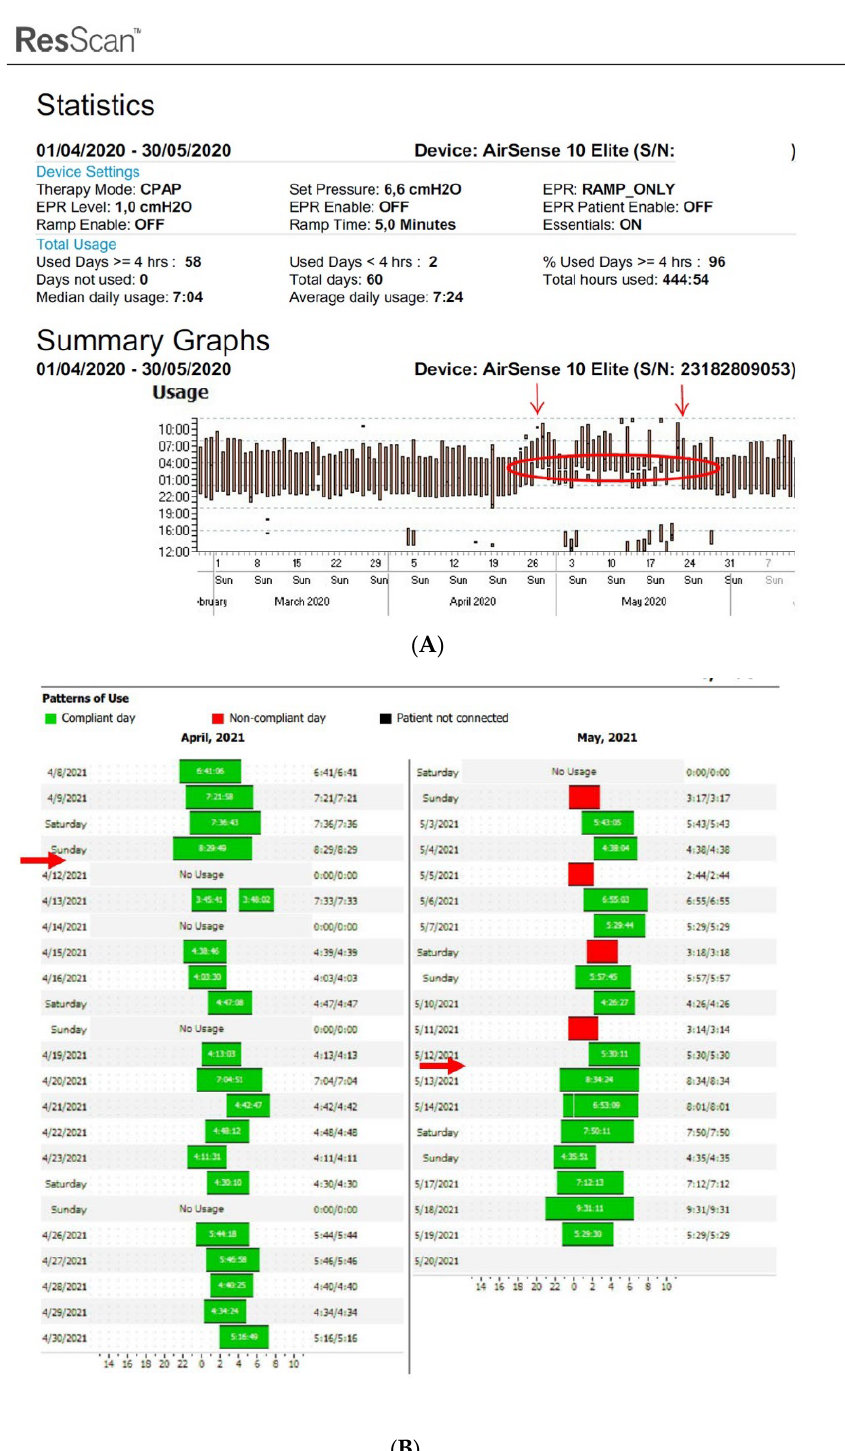
Figure 3. Sleep patterns of CPAP-treated patients suffering from maintenance insomnia. Frequent naps are also observed. CPAP data are collected from Resmed ( A ) and Philips ( B ) devices. AHI: apnea–hypopnea index, Avg: average, CA: central apnea, OA: obstructive apnea.